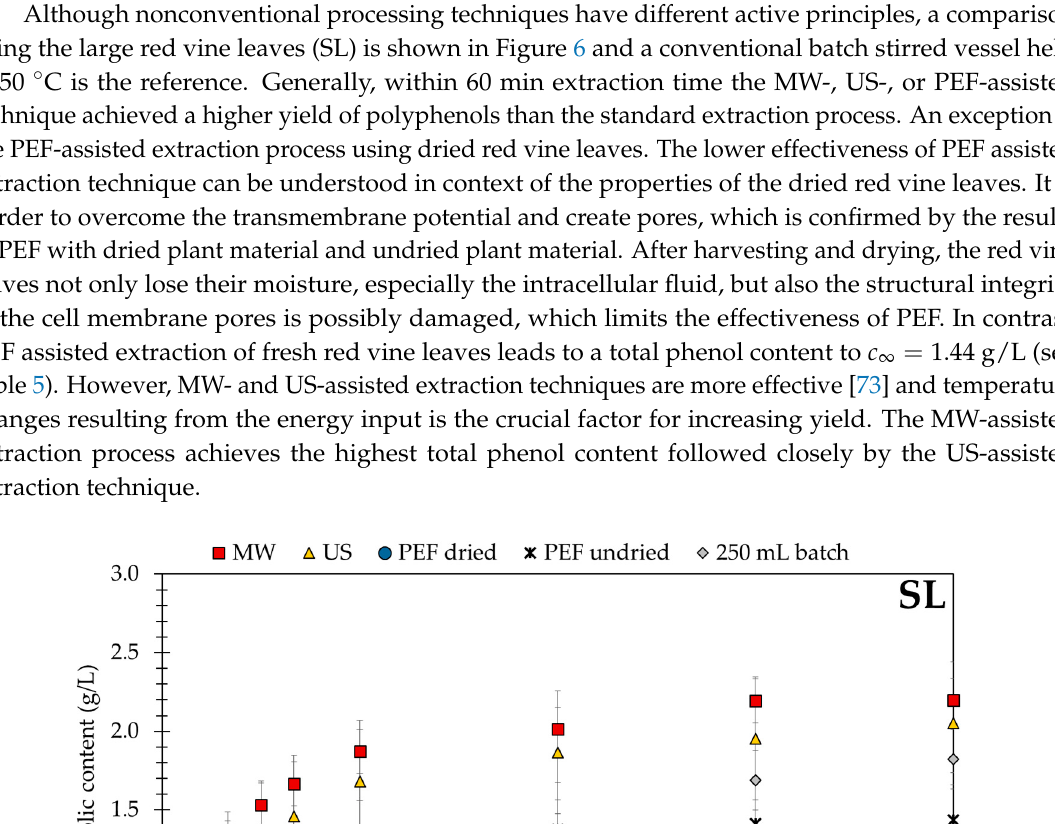
Table 5. Comparison of techniques.